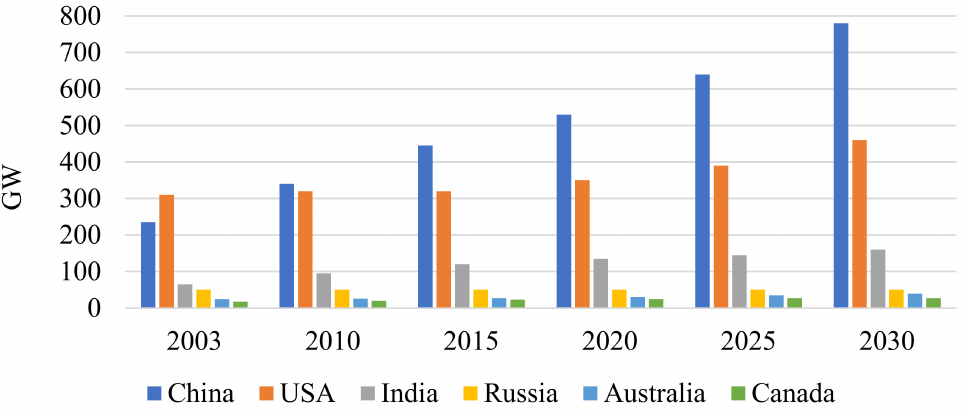
Figure 2. Growth of coal-fired power plants’ installed